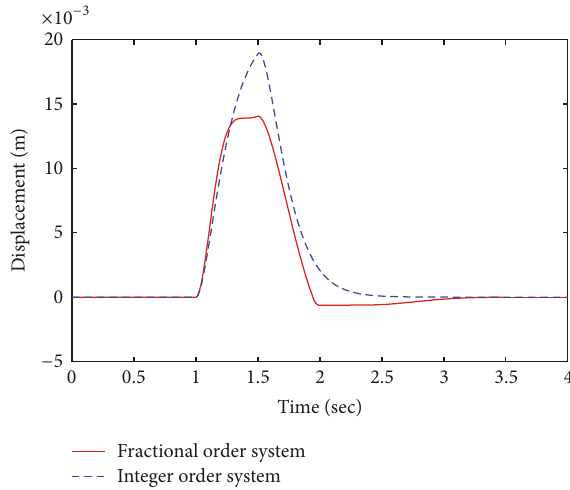
Figure 5: Impulse response curves of integer order and fractional orders switched